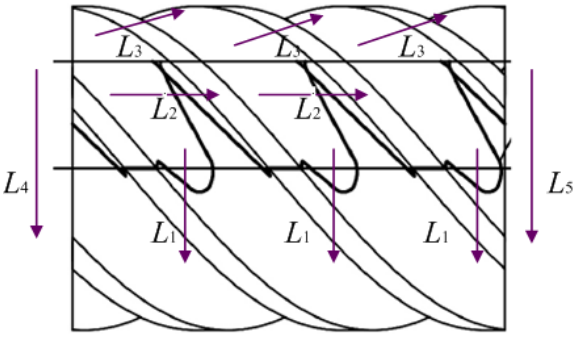
Figure 5. The schematic diagram of leakage channel.